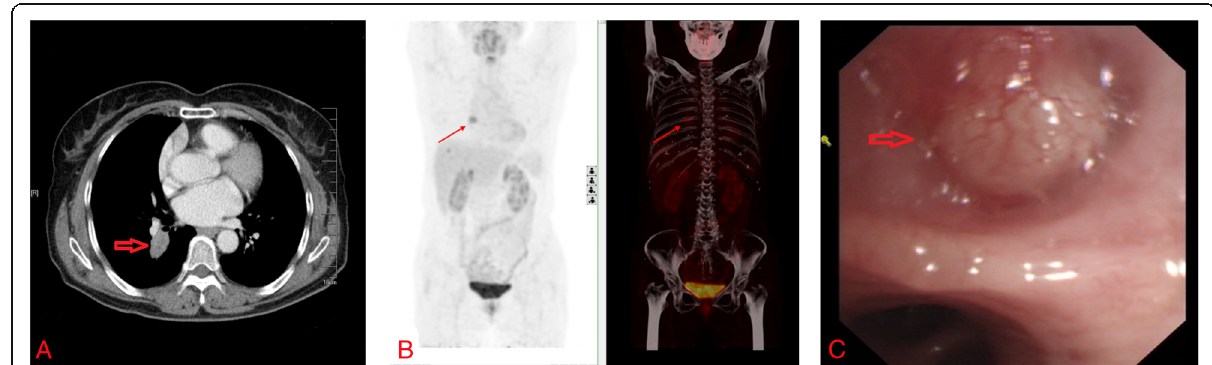
Fig. 1 A Chest CT scan revealed an interval enlargement of a 2.8-cm dorsal segment of the right lower lobe mass (red arrow). B PET-CT showed